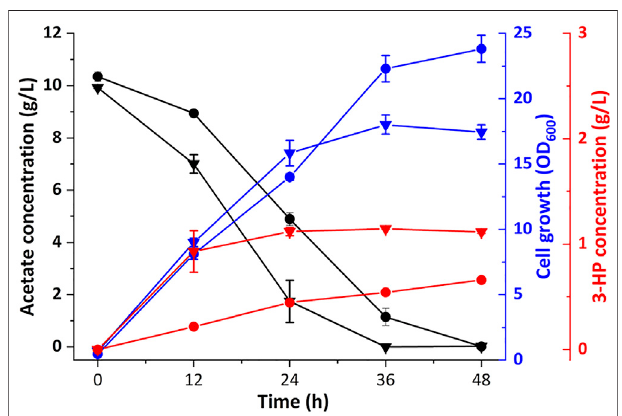
FIGURE4| Effectdelineationsofderegulationof acc .Timepro fi lesofcell growth (OD 600 ), acetate, and 3-HP concentrations of recombinant strains Cgz2/sod-N-C*andCgz13/sod-N-C*.CirclesindicatestrainCgz2/sod-N-C*. Triangles indicate strain